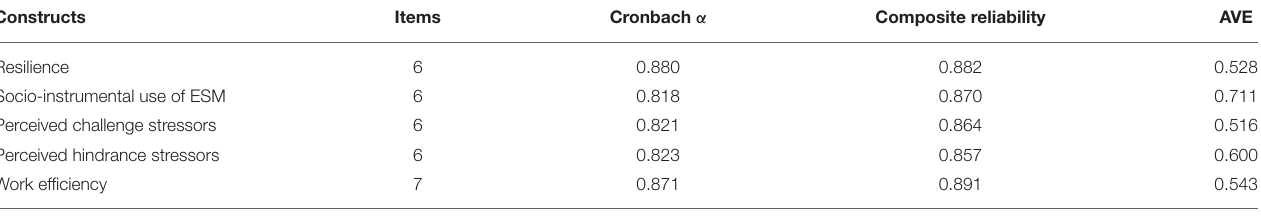
AV, Average Variance Extracted (AVE).